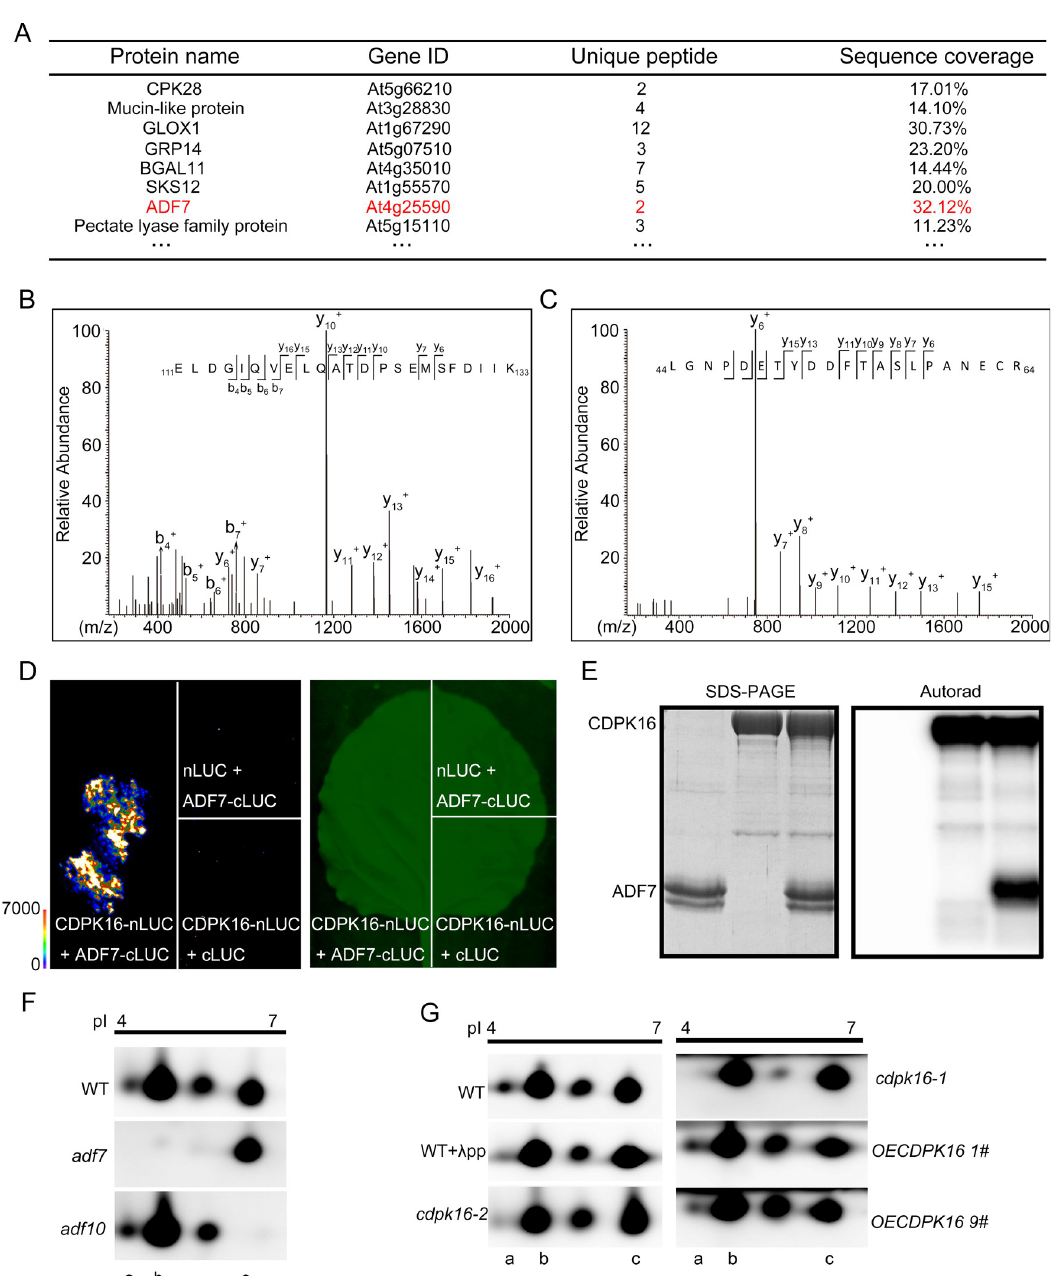
Fig 2. CDPK16 interacts with and phosphorylates ADF7. ( A ) Identification of proteins in CDPK16-6 × His pull-down fractions by LC-MS/MS. ADF7 is one of the proteins that appears in the pull-down fraction. ( B , C ) Two representative peptides derived from ADF7 are presented. A full list of the peptides is presented in S2 Data. ( D ) CDPK16 interacts with ADF7. The interaction between ADF7 and CDPK16 was determined by qualitative analysis of luciferase (LUC) activity using the LCI assay. ( E ) CDPK16 phosphorylates ADF7 in vitro . The left panel shows the CDPK16-6 × His and ADF7 input proteins, which were detected by Coomassie Brilliant blue R 250 staining. The right panel shows phosphorylated ADF7, which was detected by [ γ - 32 P] ATP autoradiography. The original pictures are available in S1 Raw Images. ( F ) Detection of ADF7 and ADF10 protein spots by 2D gel- electrophoresis. Total proteins from WT, adf7 and adf10 pollen were separated by 2D gel-electrophoresis. Protein spots were revealed by western blot analysis probed with anti-ADF7 antibody, which also detects ADF10. The original pictures are available in S1 Raw Images. ( G ) Detection of ADF7 and ADF10 in total proteins extracted from WT and cdpk16 pollen. Total proteins from WT pollen in the presence and absence of λ pp or from pollen of cdpk16 mutants and CDPK16 overexpressors were separated by 2D gel- electrophoresis and subjected to western blot analysis probed with anti-ADF7 antibody. (a), (b), and (c) in ( F ) and ( G ) represent phosphorylated ADF7, ADF7, and ADF10, respectively. The original pictures are available in S1 Raw Images. ADF, actin-